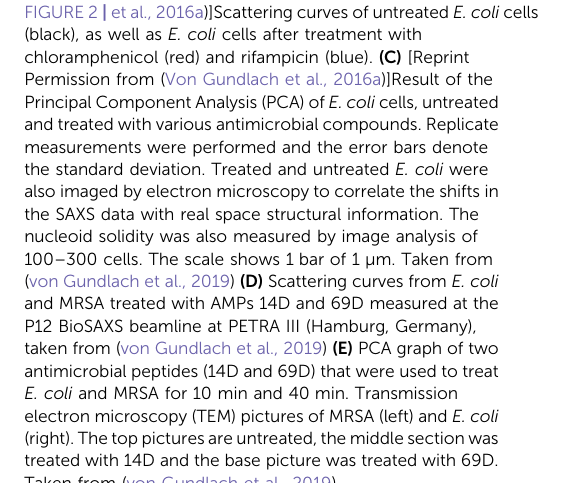
FIGURE 2 | et al., 2016a)]Scattering curves of untreated E. coli cells (black), as well as E. coli cells after treatment with chloramphenicol (red) and rifampicin (blue). (C) [Reprint Permission from (Von Gundlach et al., 2016a)]Result of the Principal Component Analysis (PCA) of E. coli cells, untreated and treated with various antimicrobial compounds. Replicate measurements were performed and the error bars denote the standard deviation. Treated and untreated E. coli were also imaged by electron microscopy to correlate the shifts in the SAXS data with real space structural information. The nucleoid solidity was also measured by image analysis of 100 – 300 cells. The scale shows 1 bar of 1 µm. Taken from (von Gundlach et al., 2019) (D) Scattering curves from E. coli and MRSA treated with AMPs 14D and 69D measured at the P12 BioSAXS beamline at PETRA III (Hamburg, Germany), taken from (von Gundlach et al., 2019) (E) PCA graph of two antimicrobial peptides (14D and 69D) that were used to treat E. coli and MRSA for 10 min and 40 min. Transmission electron microscopy (TEM) pictures of MRSA (left) and E. coli (right).Thetoppicturesareuntreated,themiddlesectionwas treated with 14D and the base picture was treated with 69D. Taken from (von Gundlach et al.,